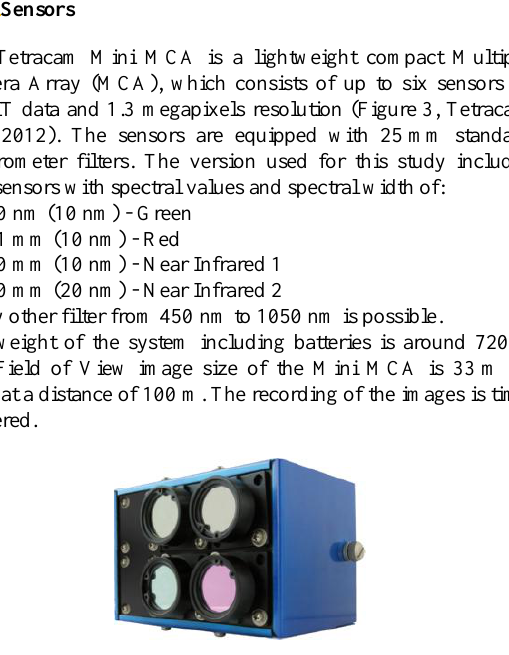
Figure 3. Tetracam Mini MCA (Tetracam Inc., 2012)